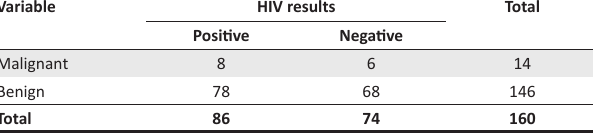
FIGURE 1: Histology results in HIV-infected (red) and HIV-uninfected patients (blue). TABLE 1: The association between malignancy and HIV status. Variable